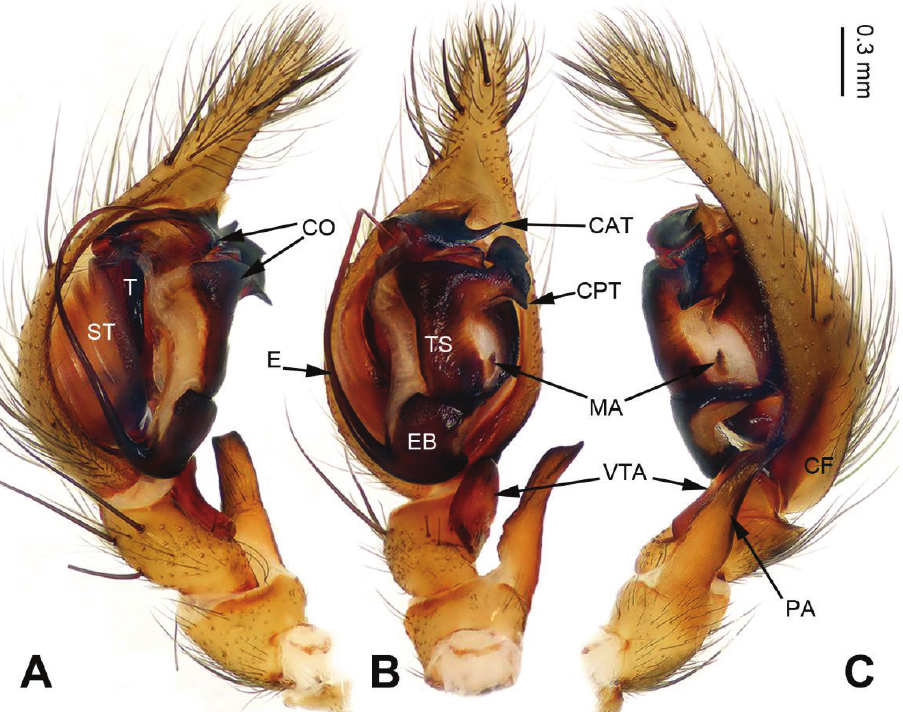
Figure 3. Palp of Longicoelotes kulianganus , specimen from Guling. A Prolateral view B Ventral view C Retrolateral view. CAT = anterior tip of conductor, CF = cymbial furrow, CO = conductor, CPT = posterior tip of conductor, E = embolus, EB = embolic base, MA = median apophysis, PA = patellar apo- physis, ST = subtegulum, T = tegulum, TS = tegular sclerite, VTA = ventral tibial apophysis. Scale bar: equal for A, B, C .